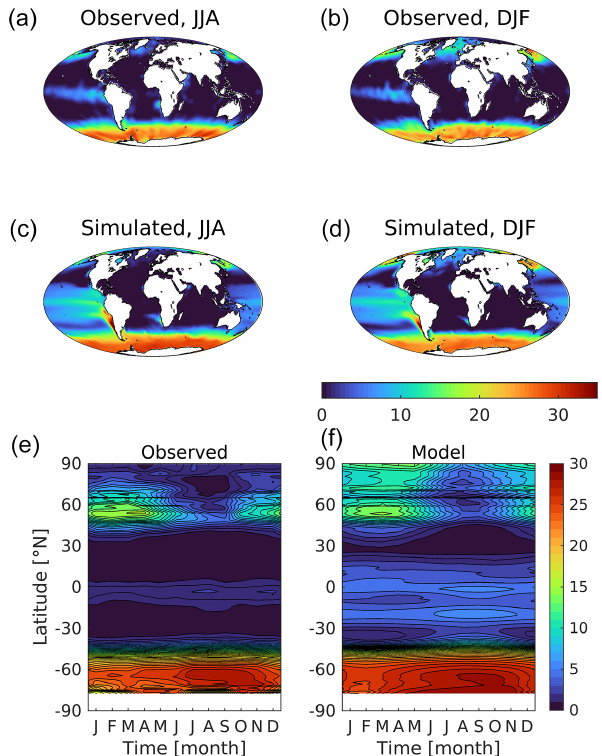
Figure 10. Observational ( a, b ; World Ocean Atlas) and simu- lated (c, d) surface dissolved inorganic nitrogen shown geograph- ically for northern ( a, c ; JJA) and southern summer ( b, d ; DJF) and as zonal Hovmöller diagrams (e, f) . Concentrations are given in mmolNm − 3